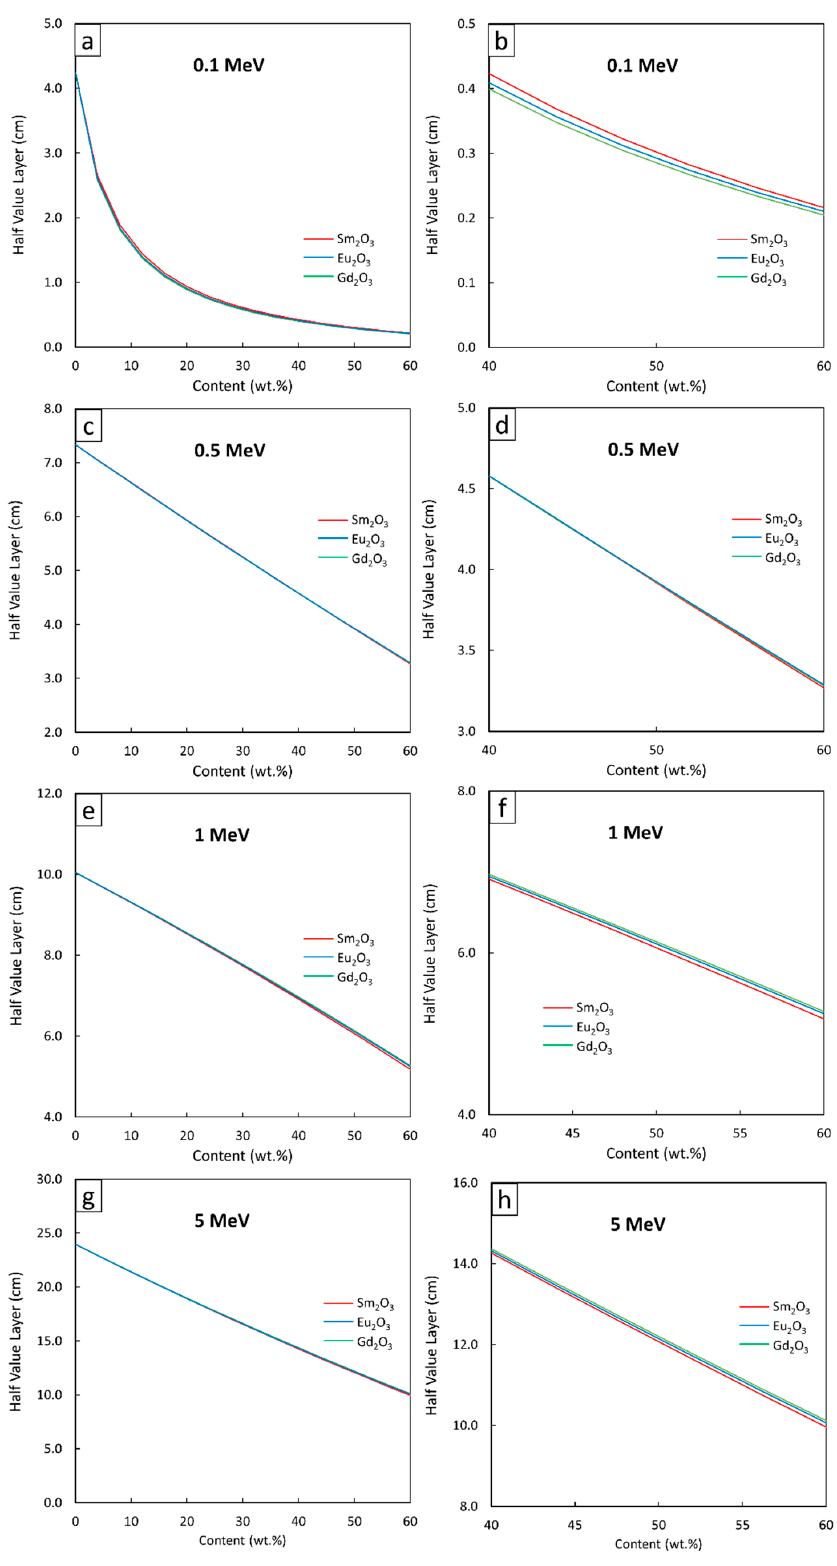
Figure 6. HVL values of Sm 2 O 3 /HDPE, Eu 2 O 3 /HDPE, and Gd 2 O 3 /HDPE composites using XCOM, with filler contents varied from ( a , c , e , g ) 0–60 wt.%, and ( b , d , f , h ) 40–60 wt.%, determined at photon energies of ( a , b ) 0.1 MeV, ( c , d ) 0.5 MeV, ( e , f ) 1 MeV, and ( g , h ) 5 MeV.